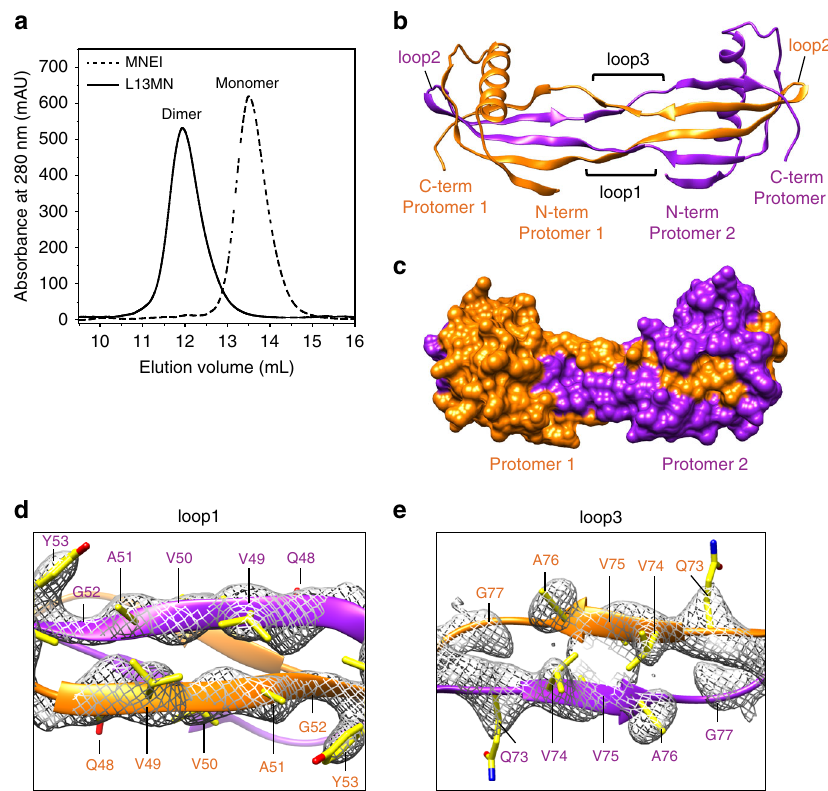
Fig. 4 Crystal structure of L13MN. a Size exclusion pro fi les of L13MN and wt MNEI at pH 7 are shown. b Ribbon representation of the crystal structure of L13MN is shown. The two polypeptide chains contributing to the swapped dimer are colored in orange and purple. The three loops, and the N-termini and C-termini of each polypeptide chain are indicated. c A space- fi lling model of the L13MN domain-swapped dimer is shown to highlight the quaternary arrangement of the protomers. Zoomed views of the hinge loops along with electron density in loop1 and loop3 are shown in d and e , respectively. Side chain nitrogen atoms are colored blue, oxygen atoms are colored red, and the rest of the side chain atoms are colored yellow. The 2Fo-Fc simulated anneal composite omit maps are shown at a contour level of 1.6 σ . Source data are provided as a Source Data fi